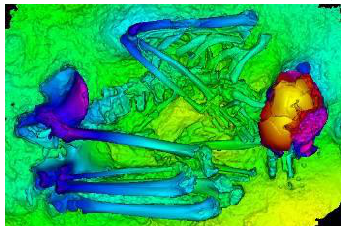
Figure 9. Digital module create contour coloured map.